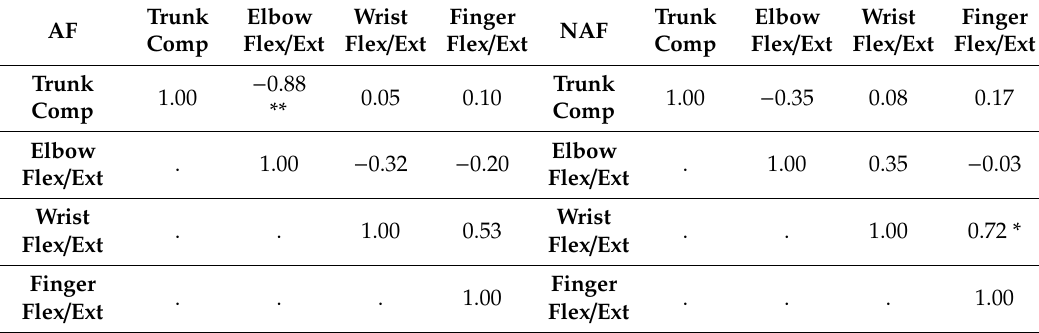
Table 4. Confusion matrix of the Spearman rank correlation coe ffi cients between the selected joint range metrics of the AF and the NAF